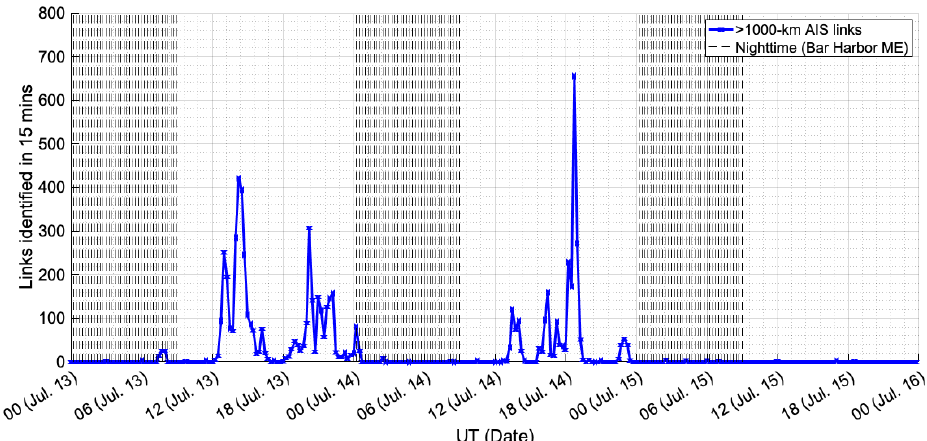
Figure 2. Figure 2 shows AIS links received from ships at over 1000km great-circle distance from USCG stations between 13–15 July 2021. The results are binned in 15min increments. Nighttime at Bar Harbor, ME, is indicated by black dashes.